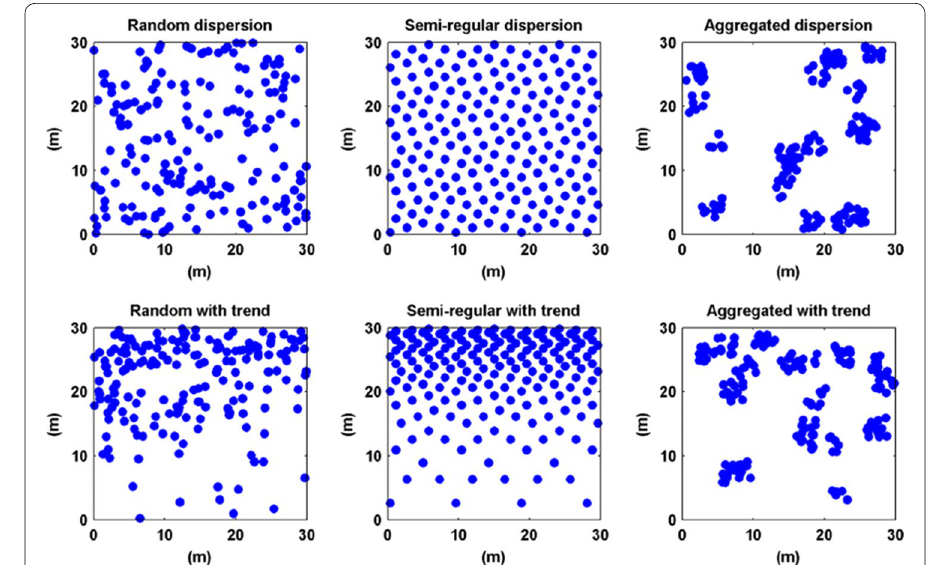
with a density trend